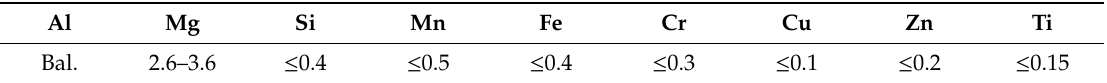
Table 1. Chemical composition of the 5754 aluminum